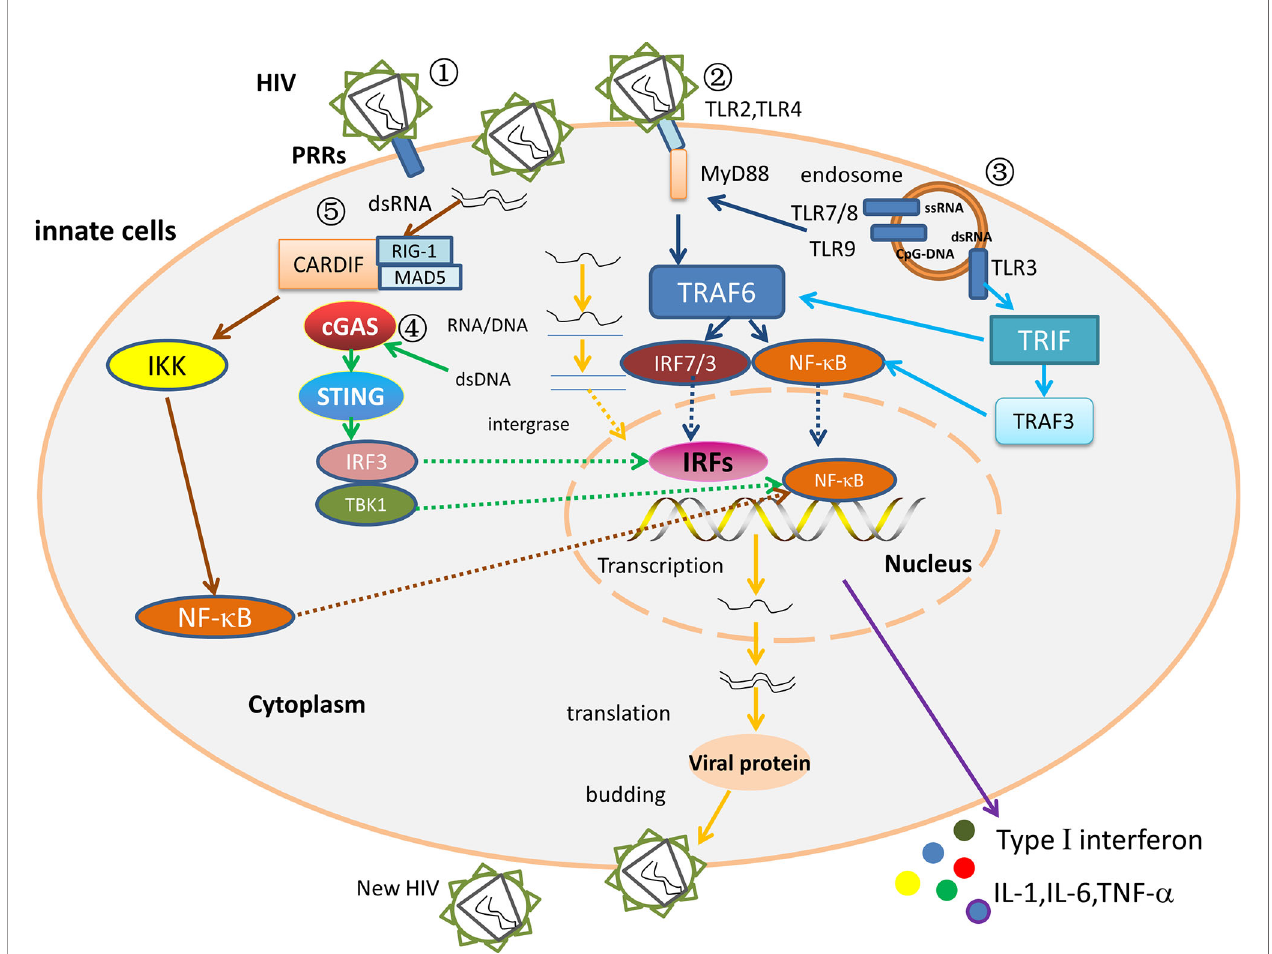
FIGURE 2 | The interaction between the innate immune factors. ① The HIV replication cycle. After PRRs recognize and bind to HIV, the viral outer membrane fuses with the cell membrane, and the viral RNA enters the cytoplasm. Under the action of reverse transcriptase, viral RNA is reverse transcribed to produce RNA-DNA hybrid strands, which are subsequently transcribed to produce double-stranded DNA. The viral double-stranded DNA integrates into the pre-viral gene of host DNA, which is then latent or transcribed into mRNA, and then translated to viral protein and packaged into a complete virus. The mature progeny virus is released to produce new HIV by budding. ② MyD88 dependent pathway. In ECs/LTNPs, HIV is recognized by TLR7/8 and TLR9, and the activated TLRs stimulate the MyD88 signaling pathway, then activate TRAF 6 and recruit NF- k B and IRF7, and increase the production of type I interferons, TNF- a , IL-1, and IL-6, thereby controlling virus replication and delaying disease progression. ③ MyD88-independent pathway in ECs or LTNPs. The dsRNA binds TLR3, then stimulates the TRIF signal pathway, raises TRAF3/TRAF6, and recruits NF- k B and IRF3 to trigger type I interferons and TNF- a . ④ The DNA receptor signaling pathway in ECs/LTNPs. The dsDNA binds cGAS, stimulates STING signal pathway, recruits IRF3/TBK1, then activates NF- k B and IRFs, and triggers type I interferons, TNF- a , IL-1, and IL-6 production, thus slowing the disease progression. ⑤ The RNA receptors signaling pathways in HIV infection. The RIG-1/MDA5 recognizes dsRNA, binds Cardif in the mitochondria, raises IKK, and activates NF- k B to trigger type I interferons production. However, the role of RLRs signaling pathway in ECs remains